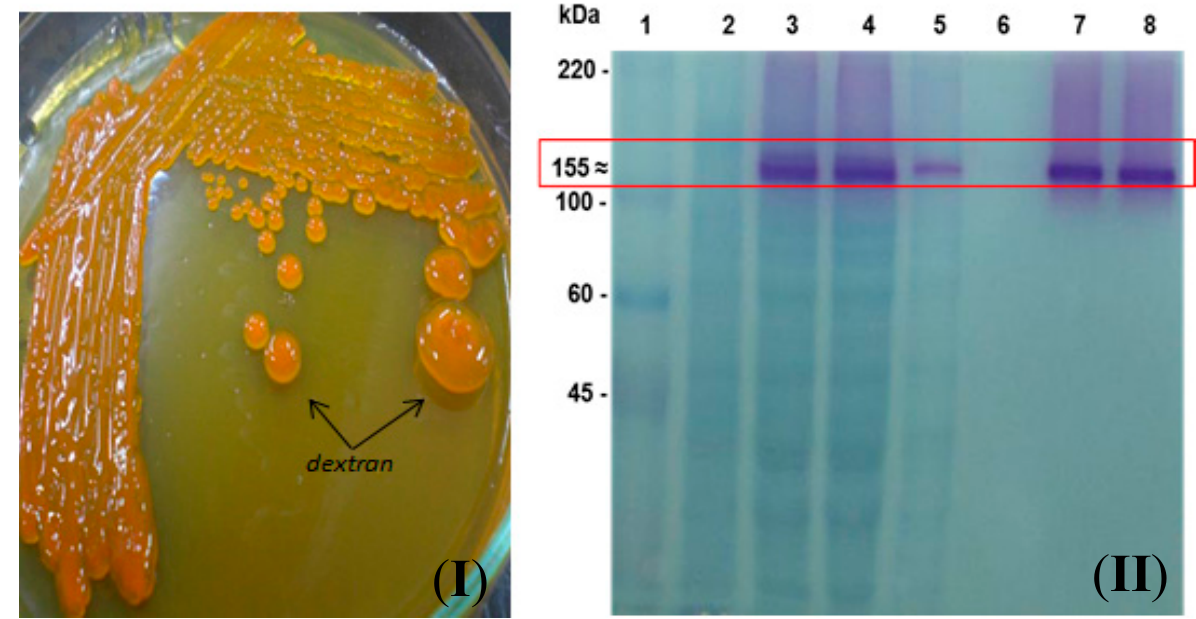
Figure 2. Production of DsrF- ∆ SP- ∆ GBD-CBM2a in E. coli DH10B. ( I ) Detection of dextransucrase activity through the formation of dextran on LBT agar plate. ( II ) SDS-PAGE of DsrF- ∆ SP- ∆ GBD-CBM2a purification, stained combining two detection methods. Zymography of the proteins with dextransucrase activity (colored bands), followed by detection of total proteins by negative staining with imidazole and zinc sulfate salts (transparent bands). The formation of the dextran polymer demonstrates the activity of the fusion. (1) Molecular Weight Marker (ColorBurst TM , Sigma-Aldrich Co.). (2) Soluble fraction of E. coli DH10B (pSE380) cell lysate as negative control. (3) Soluble fraction of E. coli DH10B (pdsrF-CBD) cell lysate. (4) Flowthrough fraction, not retained by the RAC. (5) Fraction of the 1st wash of the column (8 Column Volumes, CV). (6) Fraction of the 2nd wash of the column (12 CV). (7 and 8) Fractions